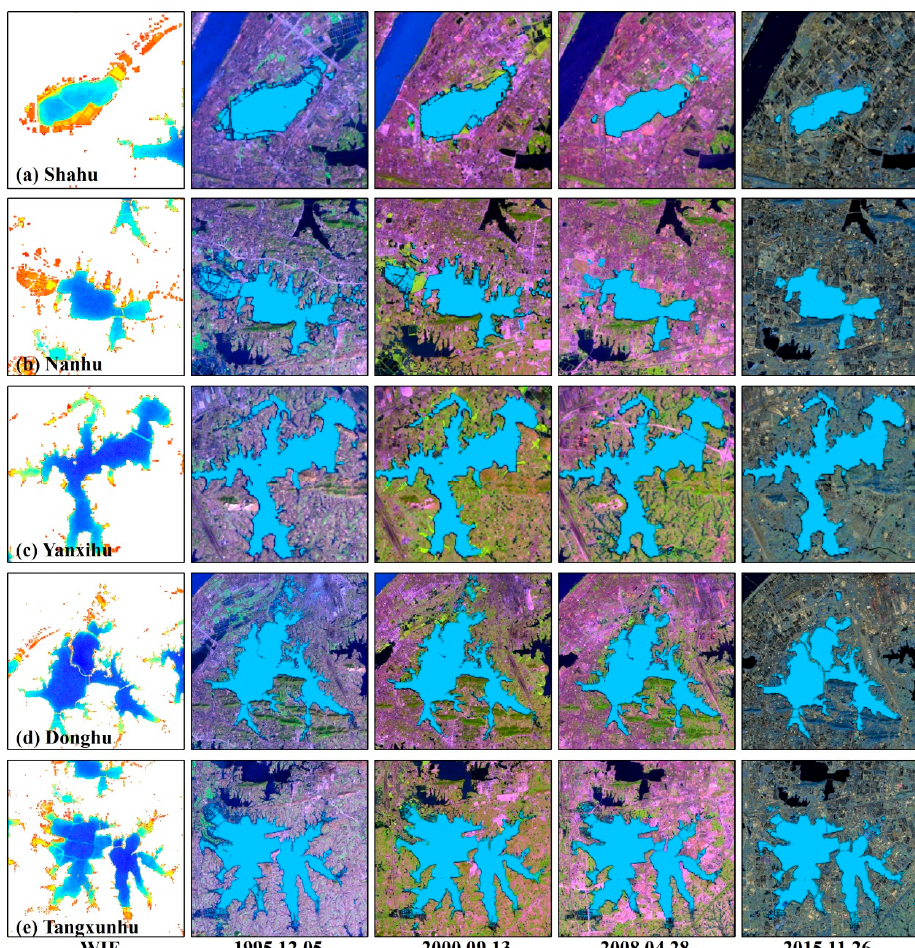
Figure 8. Lake water area changes from 1987~2015. First column represents the water inundation frequency (WIF) from 1987 to 2015 for these five lakes. The other four columns represent the composited maximum lake-water extents of these five lakes at different years: 1995, 2000, 2008, and 2015.